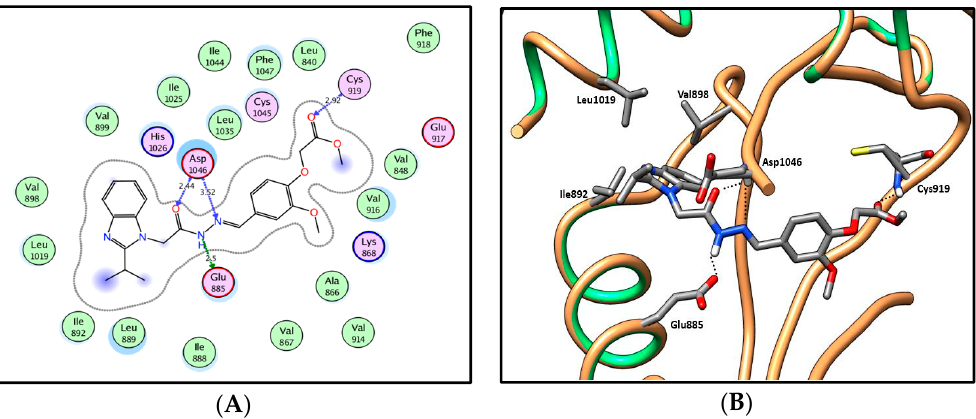
Figure 12. 2D diagram ( A ) and 3D representation ( B ) of compound 19a showing its interaction with the VEGFR-2 active site.